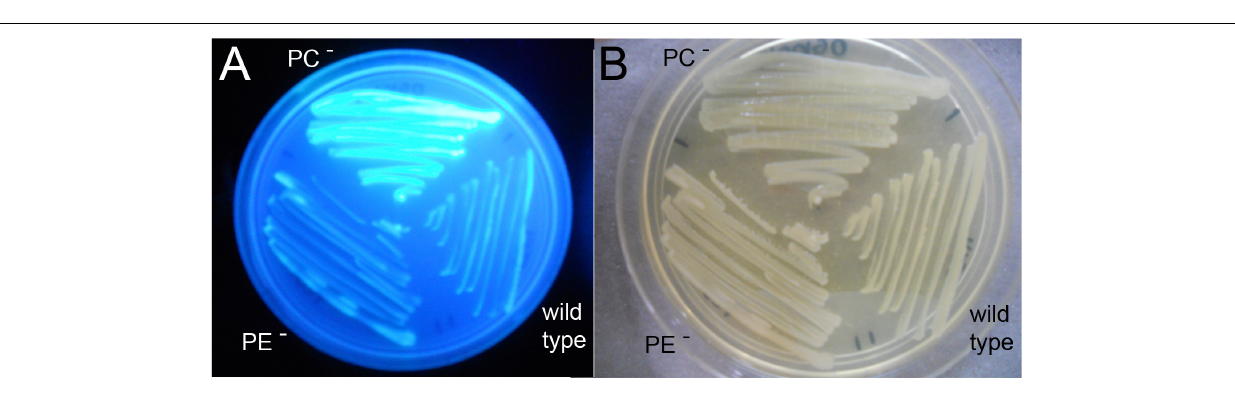
FIGURE 6 | Phosphatidylcholine (PC)-deficient mutant OG10017 shows increased succinoglycan (exopolysaccharide I) formation. S. meliloti 1021 (wild type), PC-deficient mutant OG10017, and the PE-deficient mutant CS111 were cultivated for 72 h on LB/MC+-containing agar in the presence of Calcofluor. Upon UV excitation, only the PC-deficient mutant showed much fluorescence indicating overproduction of succinoglycan (A) , whereas growth was similar for all three strains (B)